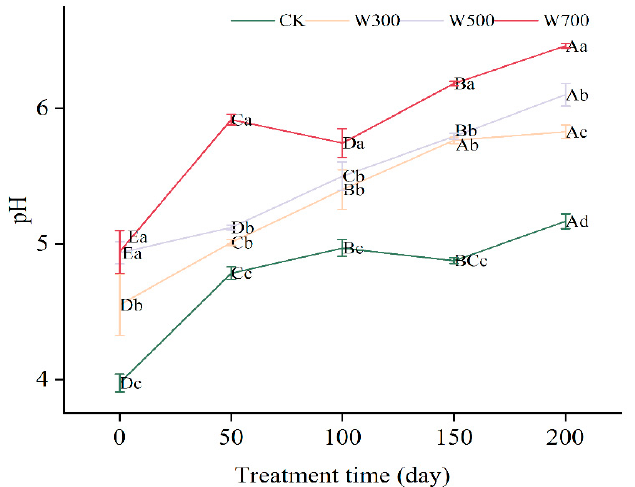
Figure 2. Effects of biochar pyrolyzed at different temperatures on soil pH values sampled at 0, 50, 100, 150 and 200 days after treatment. CK: without biochar; W300: with biochar pyrolyzed at 300 ◦ C; W500: with biochar pyrolyzed at 500 ◦ C; W700: with biochar pyrolyzed at 700 ◦ C. Different uppercase letters indicate significant differences among the different sampling times in the same treatment, while different lowercase letters indicate significant differences among the different treatments at the same sampling time according to Duncan’s test ( p < 0.05),